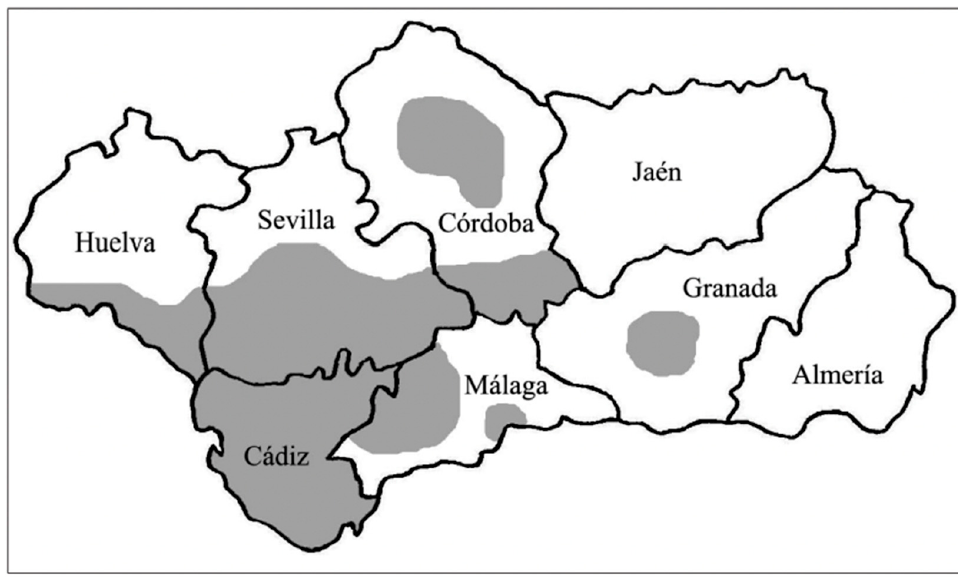
Figure 4. Jejeo distribution in Andalusian Spanish (adapted from Rodríguez Prieto 2014).